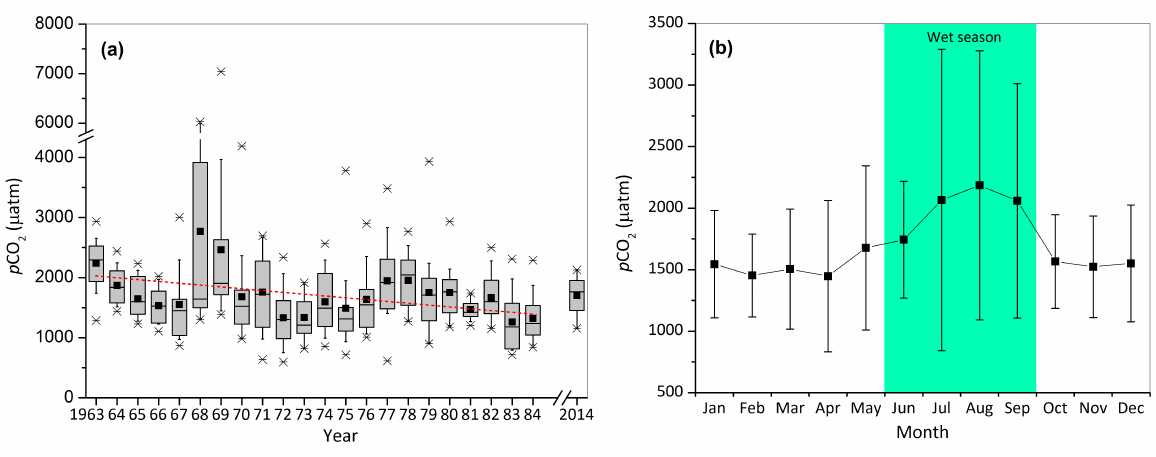
Figure 4. Temporal variations in p CO 2 at Datong station. (a) Box-and-whisker plots show significant interannual changes; (b) seasonal variations. The dash line in panel (a) represents linear regression, and the values for 2014 are derived from Liu et al. (2016). Error bars denote standard deviation.